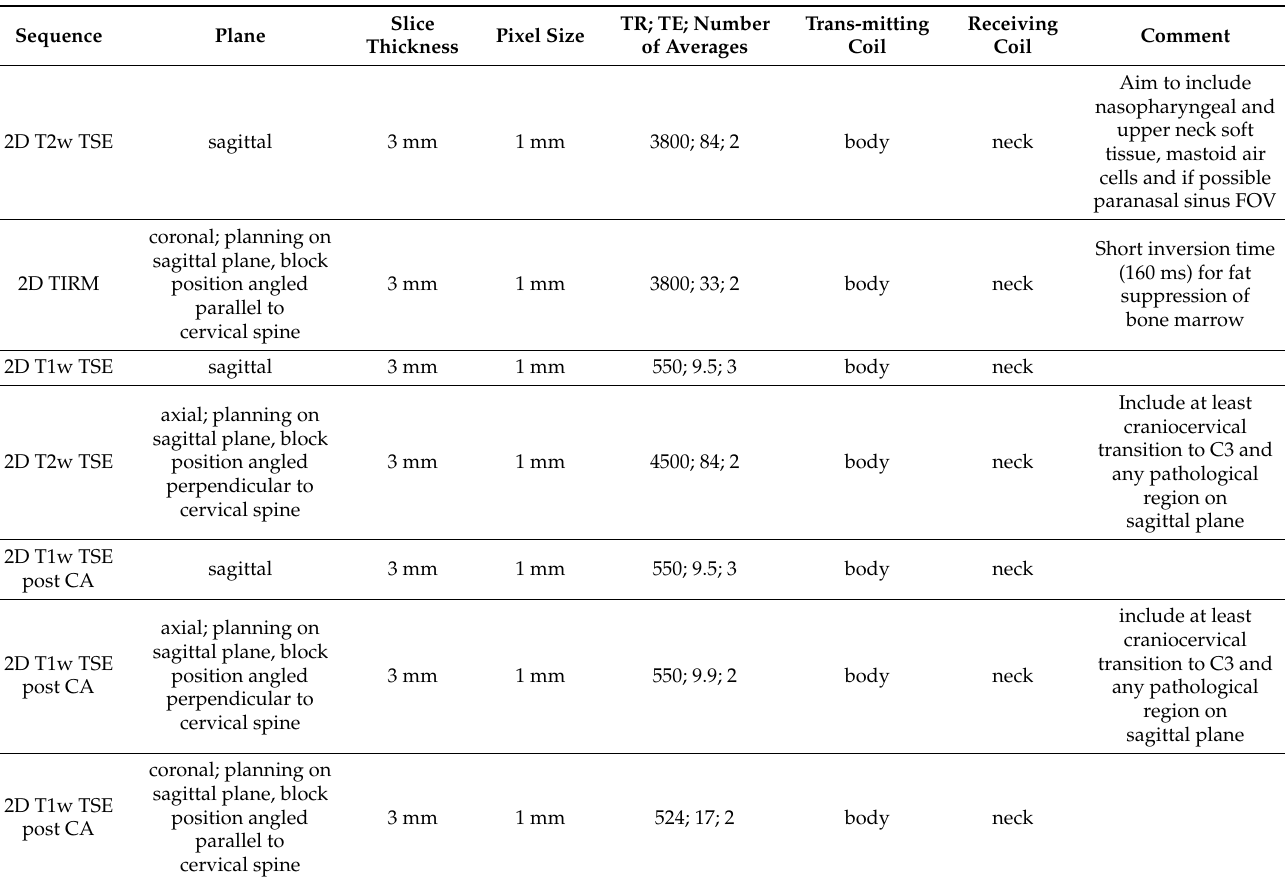
Table 1. Standardized MRI (Diagnosis and Routine Follow-Up). Suggested standard protocol with a duration of approxi- mately 23 min scan time at 1.5 Tesla (T). For smaller children, a slice thickness of 2 mm should be considered.